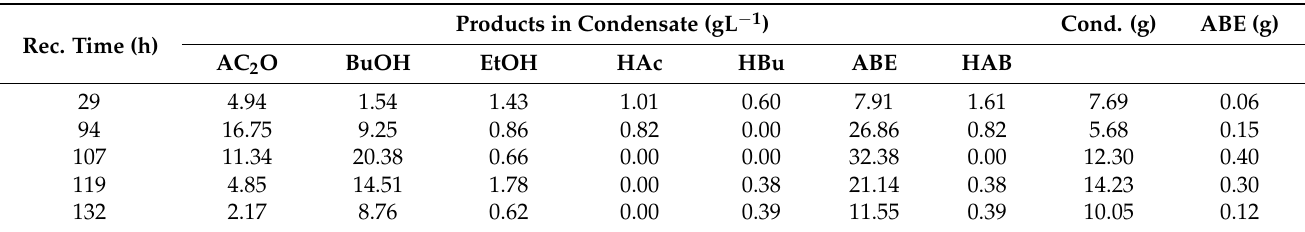
Figure 2. Production of ABE from 220 gL − 1 (22% dry wt. basis) SSB in an integrated process of simultaneous saccharification, fermentation, and recovery. ( A ) Products (acetone butanol ethanol or ABE). ABE and acid abbreviations as in Table 2; ( B ) sugars. Glu—glucose, Xyl—xylose, Arab—arabinose, Tot. Sug.—total sugar. Table 2. Concentrations of ABE in the recovered condensates at various fermentation times during simultaneous SSB saccharification, fermentation, and